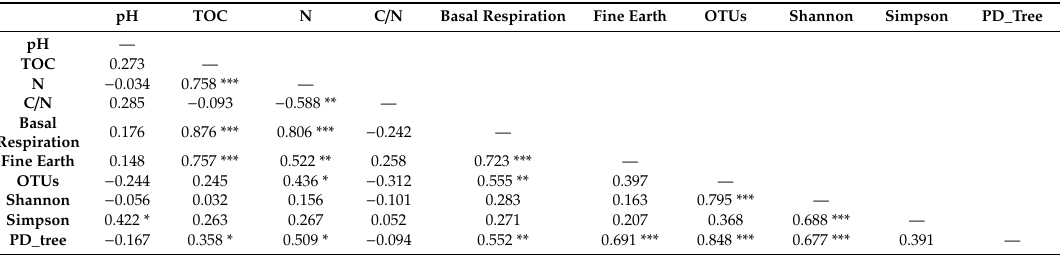
Table 5. Correlation matrix between soil parameters and microbial alpha-diversity indices. pH TOC N C / N Basal Respiration Fine Earth OTUs Shannon Simpson